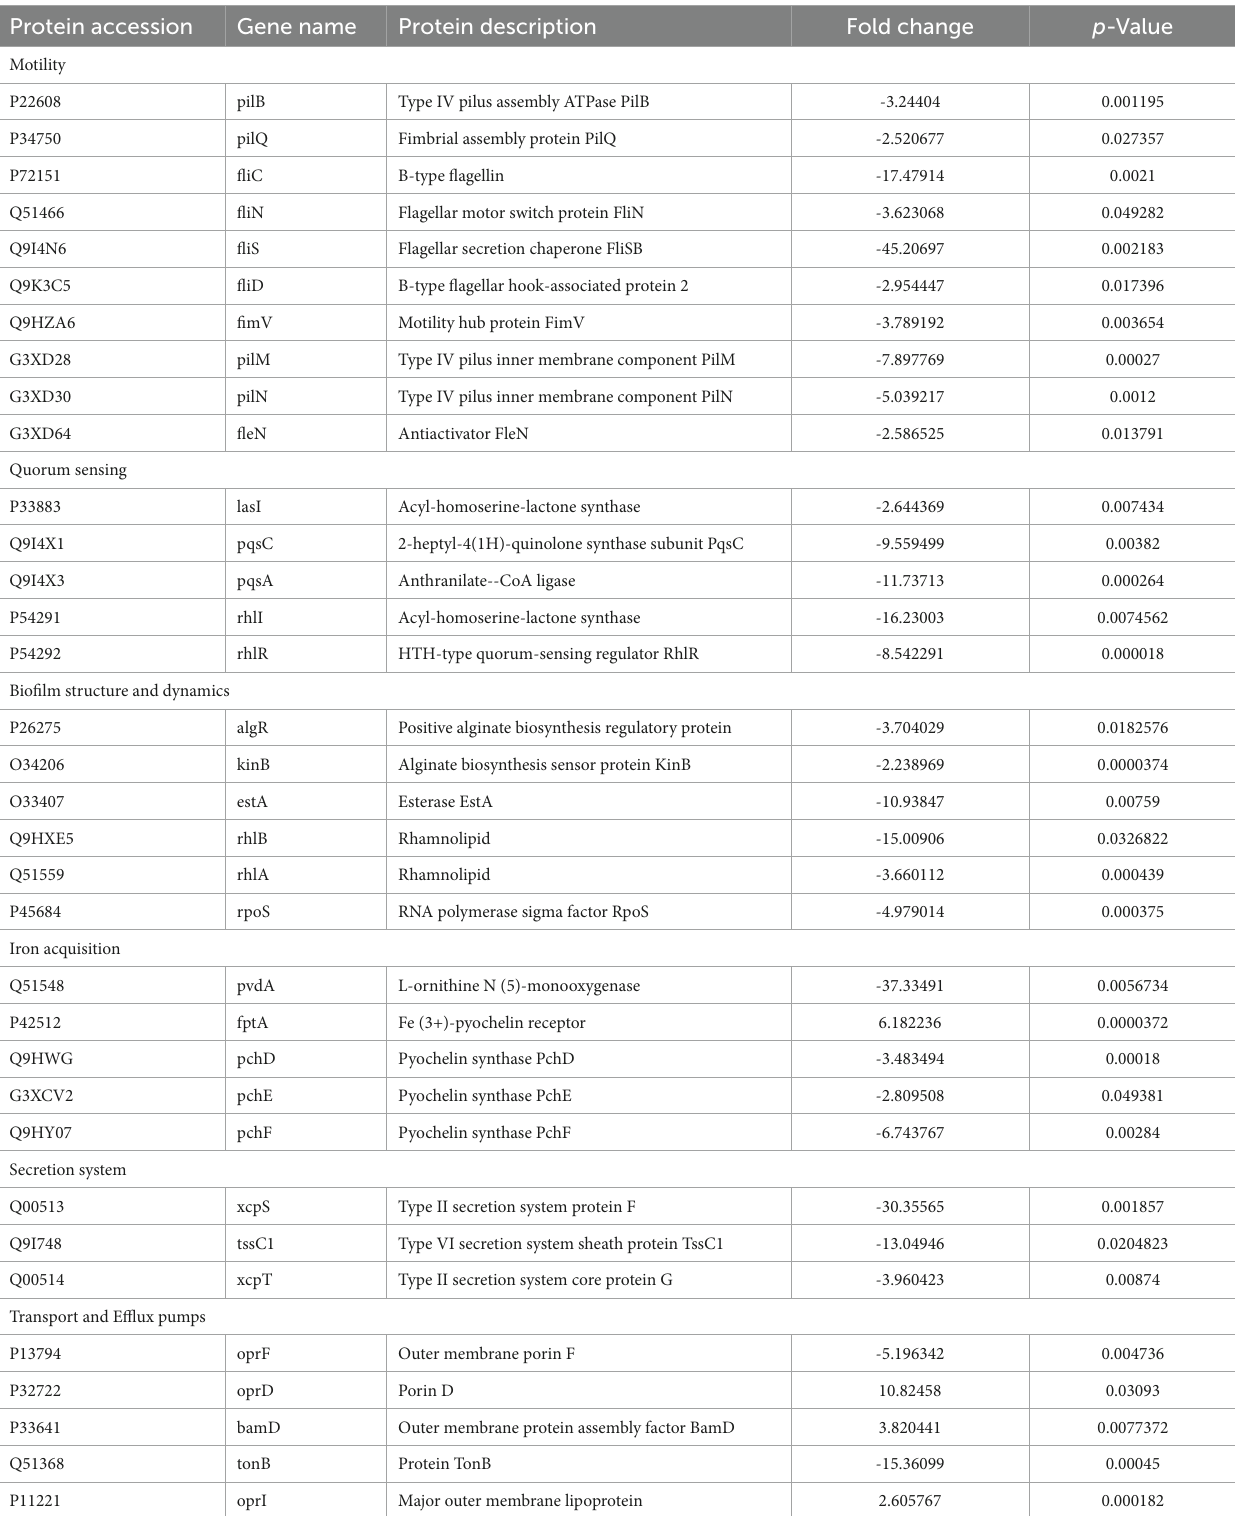
TABLE 1 Pseudomonas aeruginosa biofilm-related proteins and other virulence factors that were significantly expressed (> 1.5-fold change) after challenging with Nissle cell-free